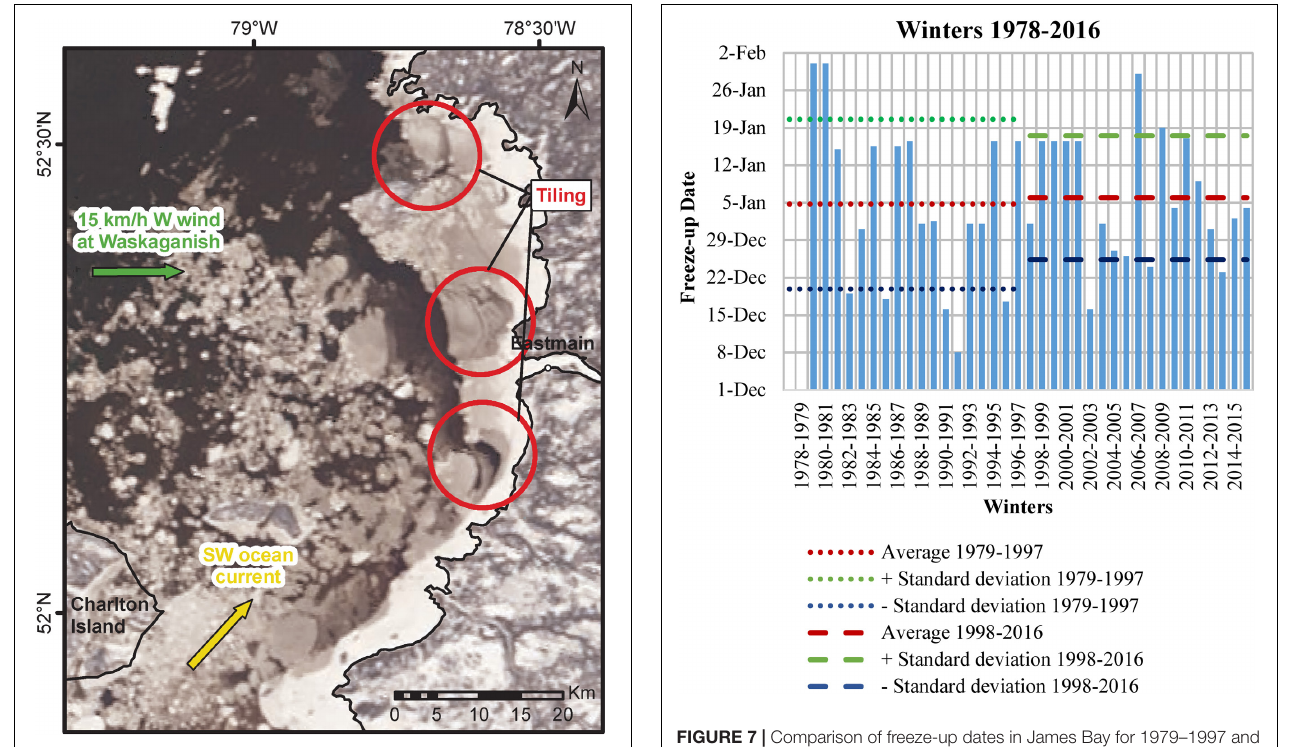
FIGURE 6 | Modis image from December 3, 2013 showing the formation of the southeastern coastal ice cover by tiling adapted from Taha et al. (2017).